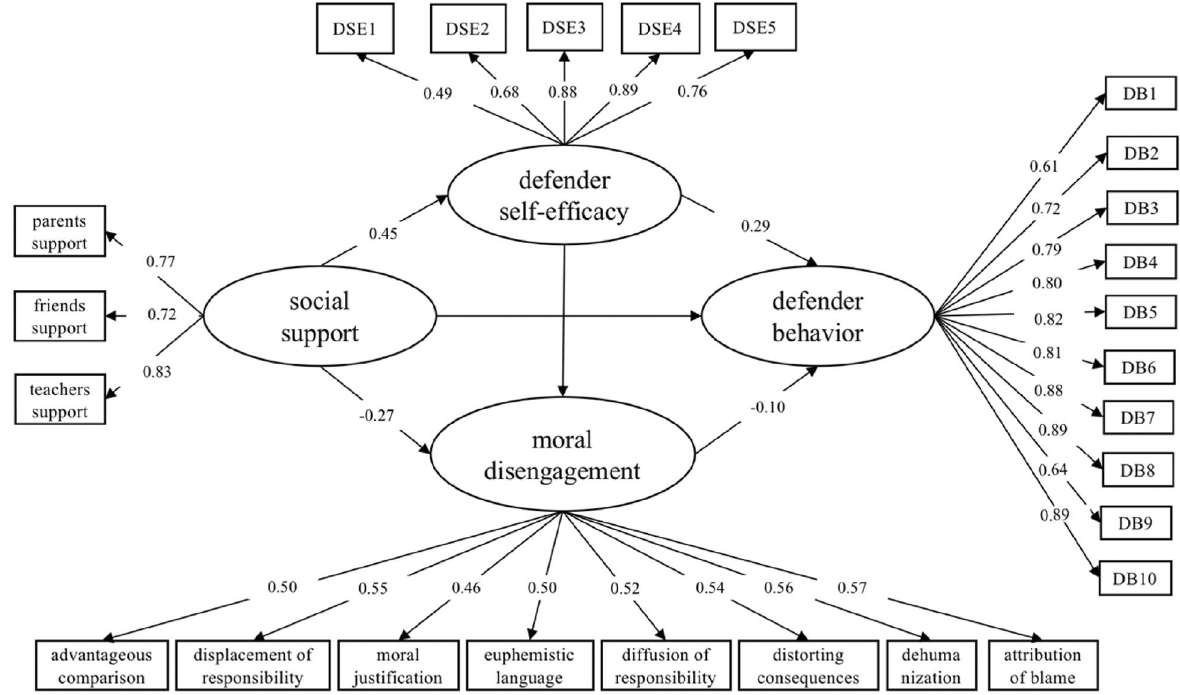
Fig. 3 The mediating effect of defender self-efficacy and moral disengagement in the relationship between social support and defender